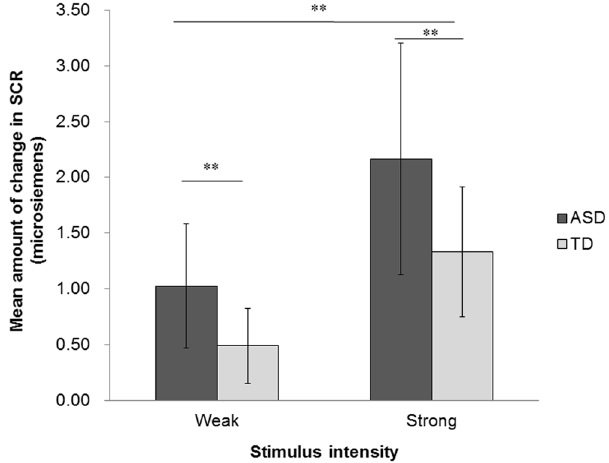
Figure 1. Mean amount of change in the SCR to electrical stimuli across groups as a function of stimulus intensity. Error bars show SD. ** p <